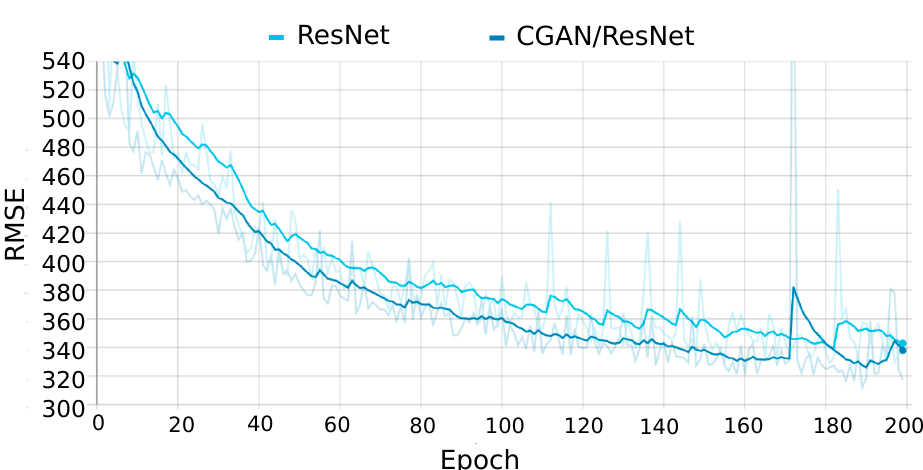
Figure 9. Comparison of the evolution of validation errors during the training phase of ResNet and CGAN with ResNet as generator (CGAN/ResNet).